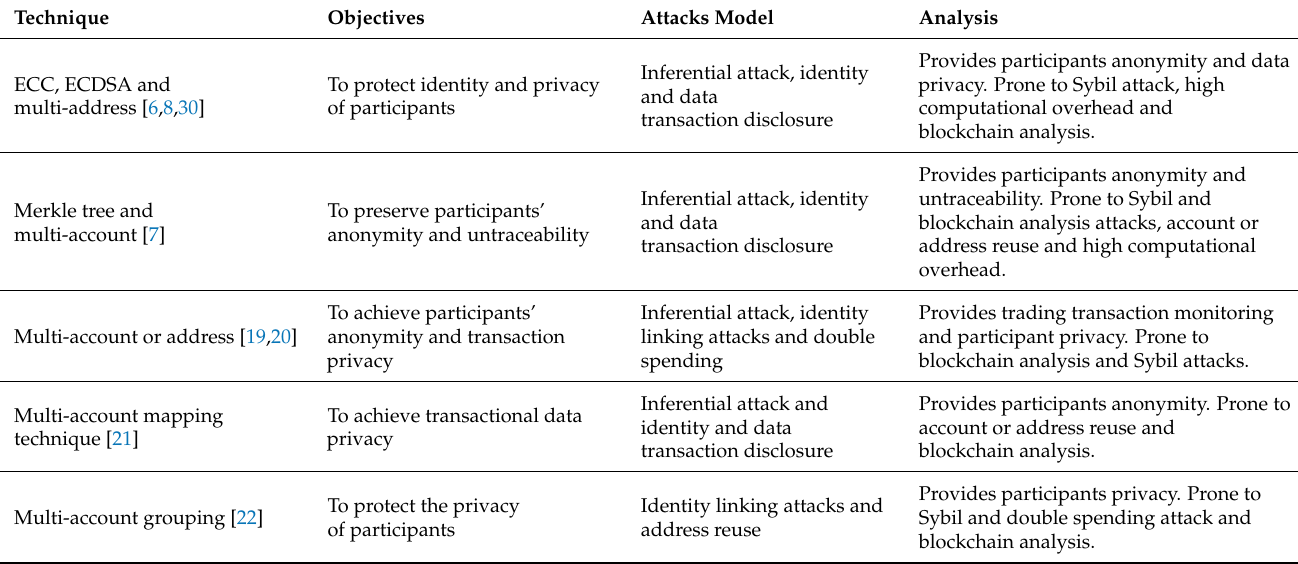
Table 1. A Summary of the blockchain-based